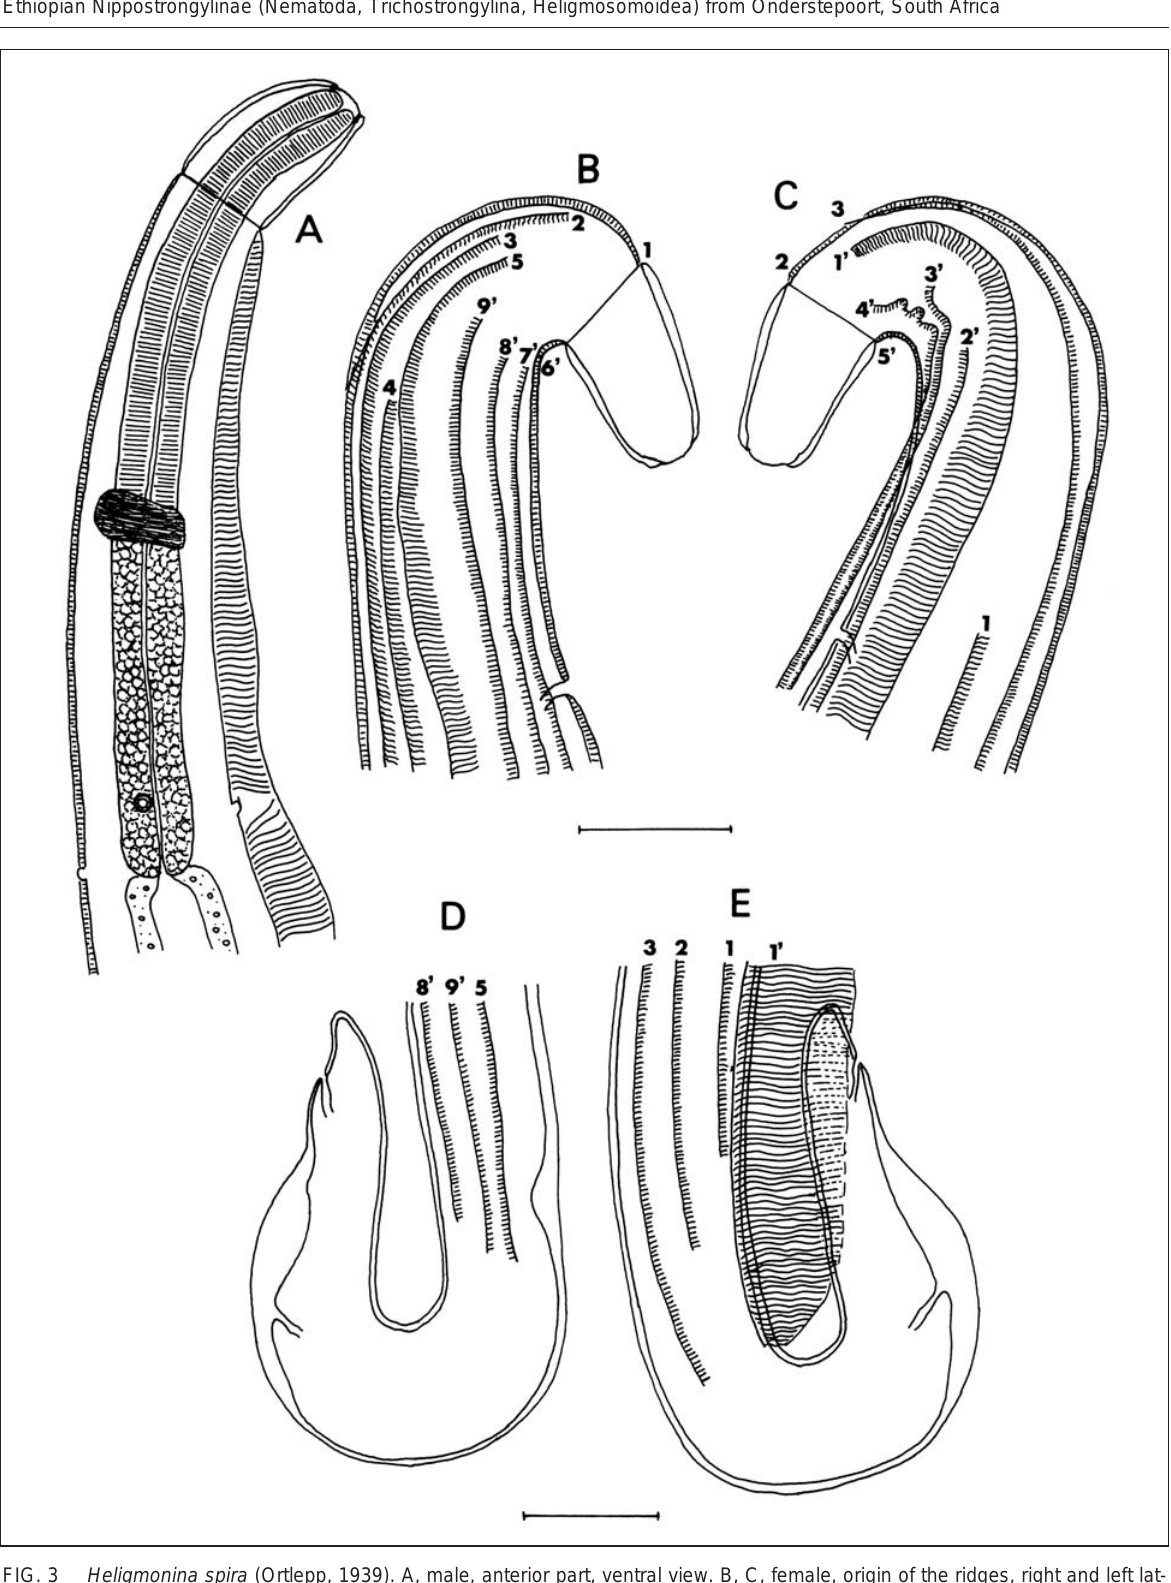
FIG. 3 Heligmonina spira (Ortlepp, 1939). A, male, anterior part, ventral view. B, C, female, origin of the ridges, right and left lat- eral views. D, E, female, area where the ridges disappear, right and left lateral views The ridges are numbered from left to right, no. 1– n for the dorsal side, no. 1’– n ’ for the ventral side Scales: A–C: 50 µm; D, E: 100